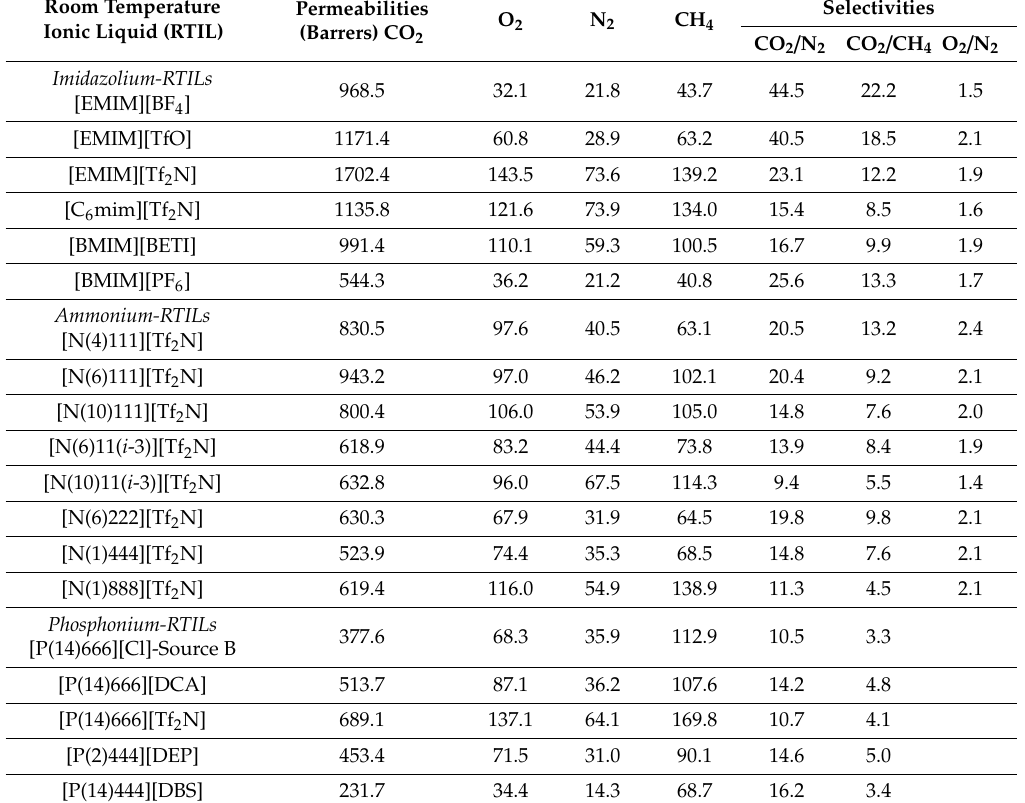
Table 6. Methane and inorganic gas permeabilities and selectivities data at 30 ◦ C. Room Temperature Ionic Liquid